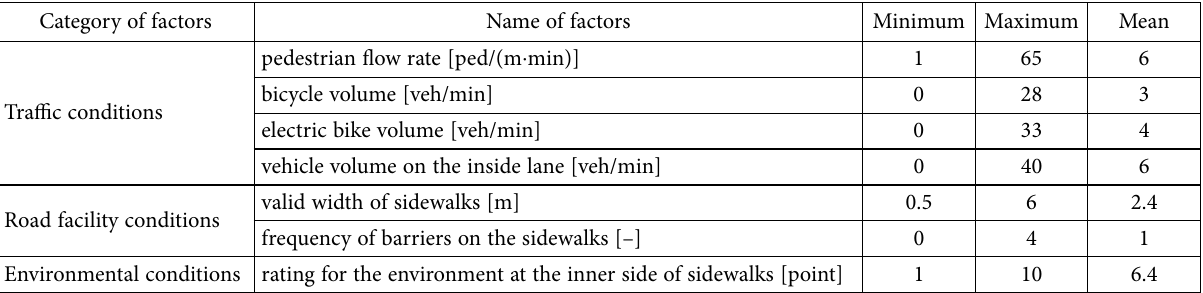
Table 3. Quantitative variables of traffic conditions, road facility conditions and environmental conditions Category of